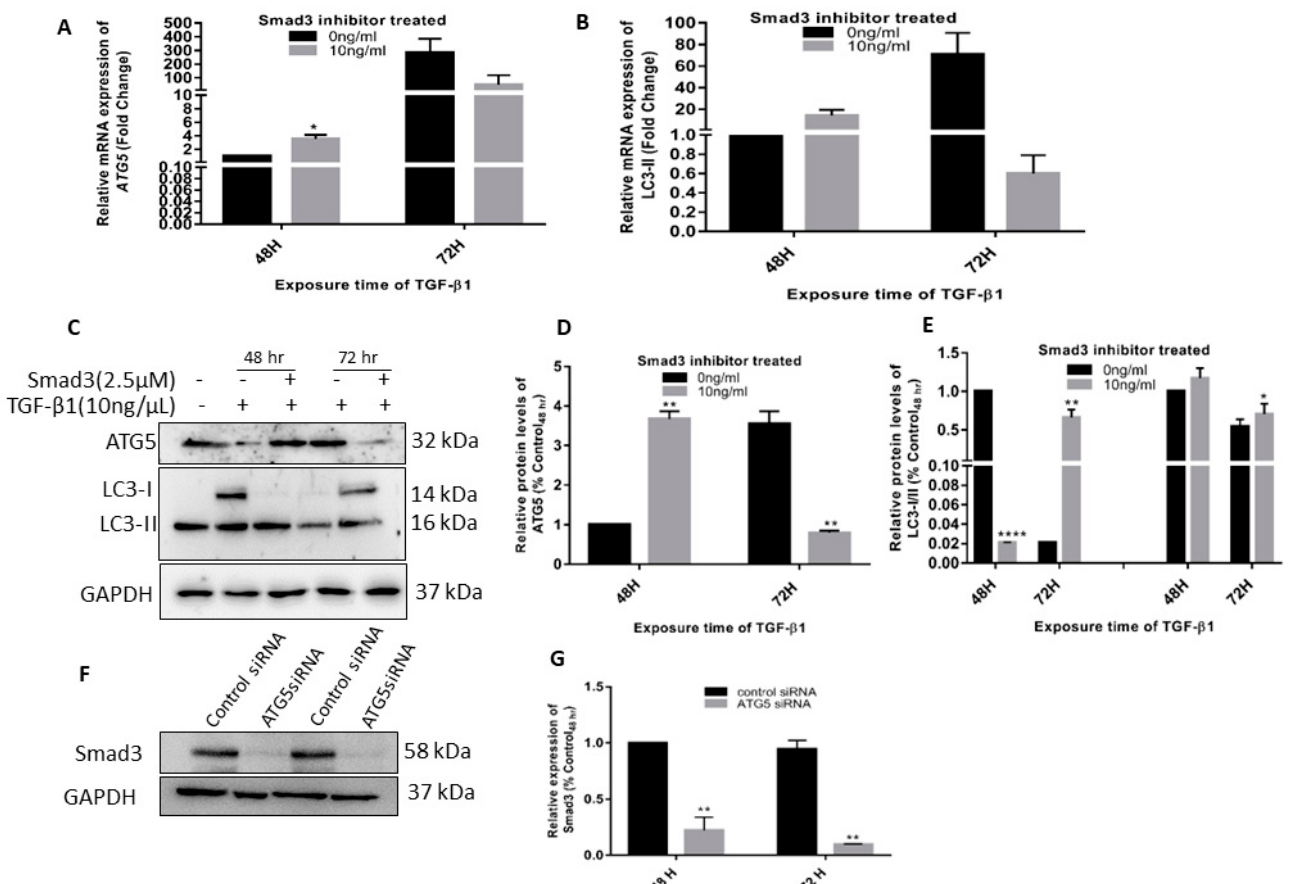
Figure 4. ATG5 regulates TGF- β 1 induced effects in HTM cells via Smad3 signaling. HTM primary cells treated with 2.5 µM Smad3 inhibitor (SIS3) and with (10 ng/mL) or without TGF- β 1 showed a relatively lower expression of autophagy markers, ( A ) ATG-5, and ( B ) LC3-II as compared to time-matched controls. ( C ) Western blot analysis of ATG-5 and LC3-I/II proteins shows a similar trend, ( D , E ) densitometry analysis of the bands, ( F ) Levels of Smad3 in ATG5 inhibited cells and ( G ) densitometry analysis of Smad3 bands. The error bars represent standard deviation (*— p < 0.05, **— p < 0.01, ****— p < 0.0001, by t -test).